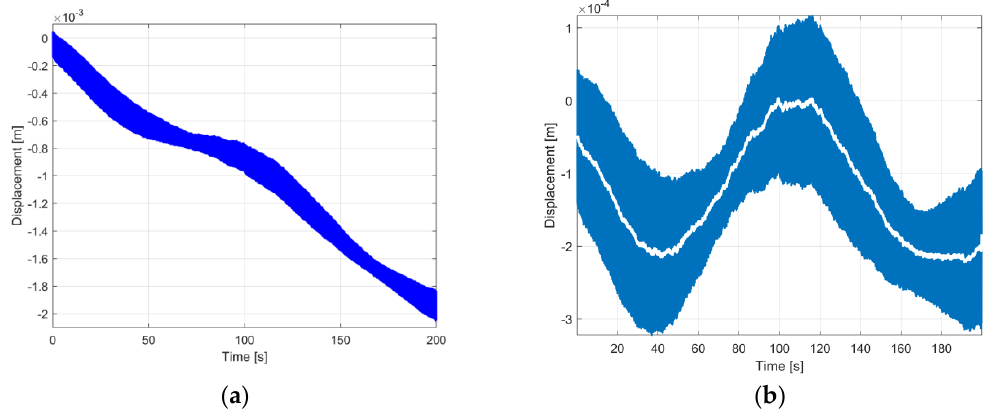
Figure 5. ( a ) The result of numerical integration of velocity evolution from Figure 3; and ( b ) the result of removing the zero-offset influence on numerical integration of velocity from Figure 5a.